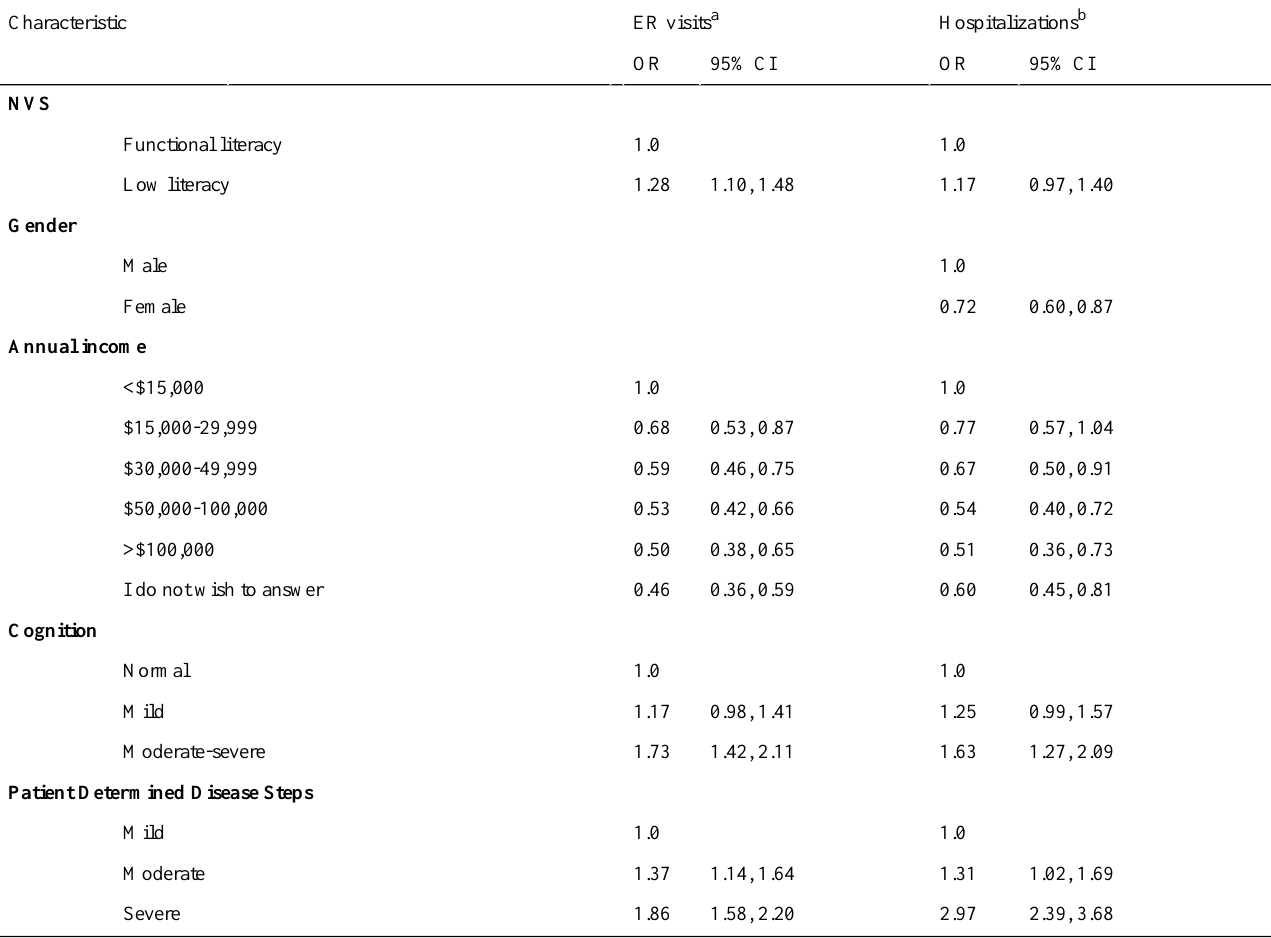
Table 6. Association of health literacy (NVS) with emergency room (ER) visits and